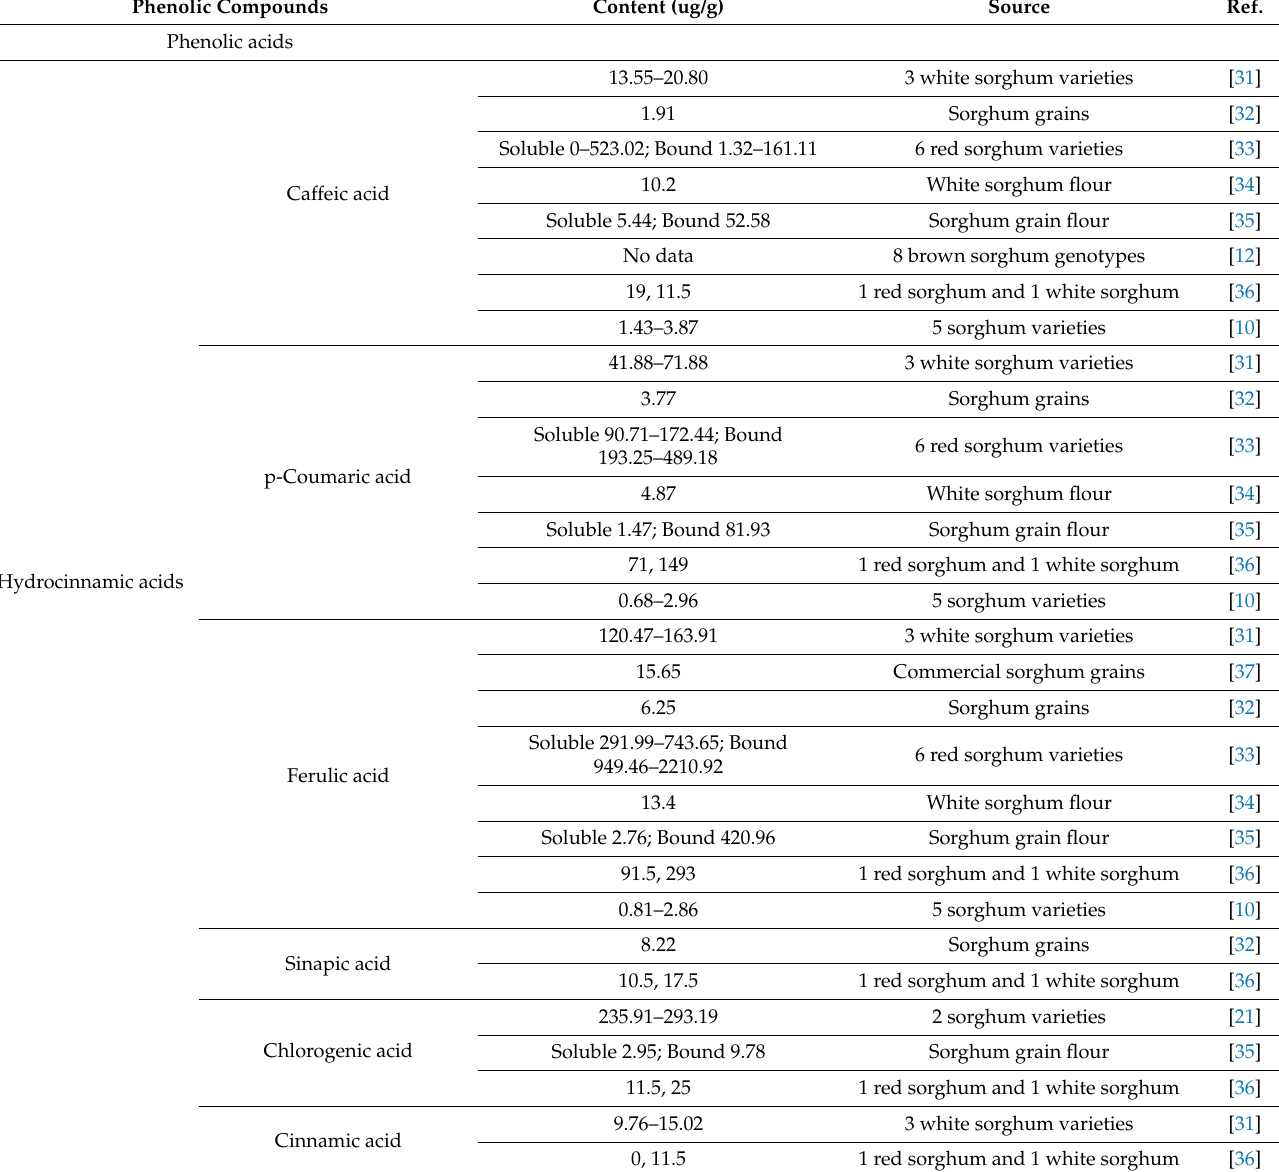
Table 2. Phenolic compounds in sorghum